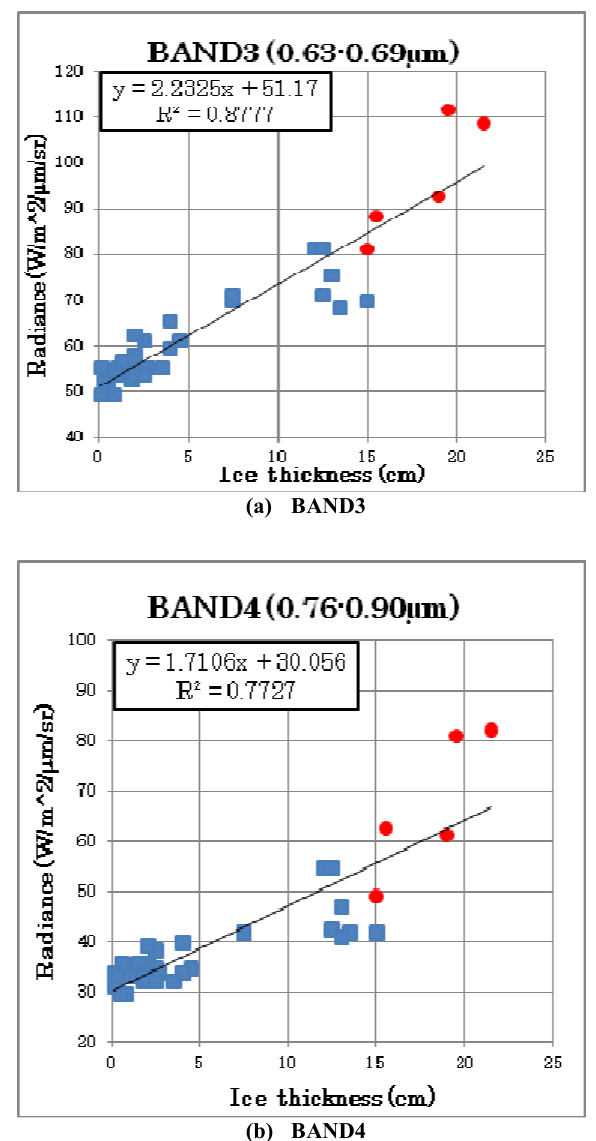
Figure 5. Relationship between ice thickness and RSI